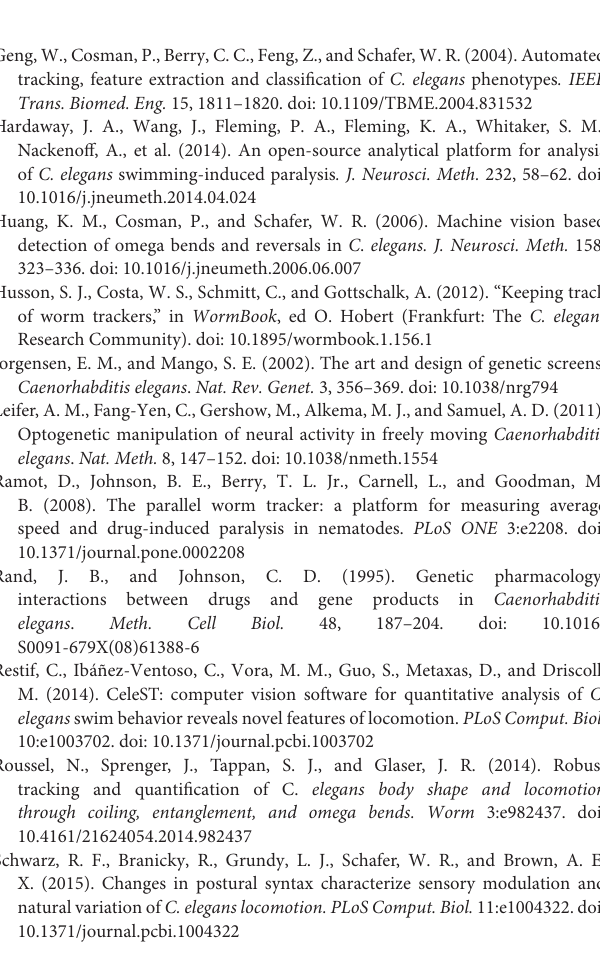
Table S1 | Tracking settings used in WormLab